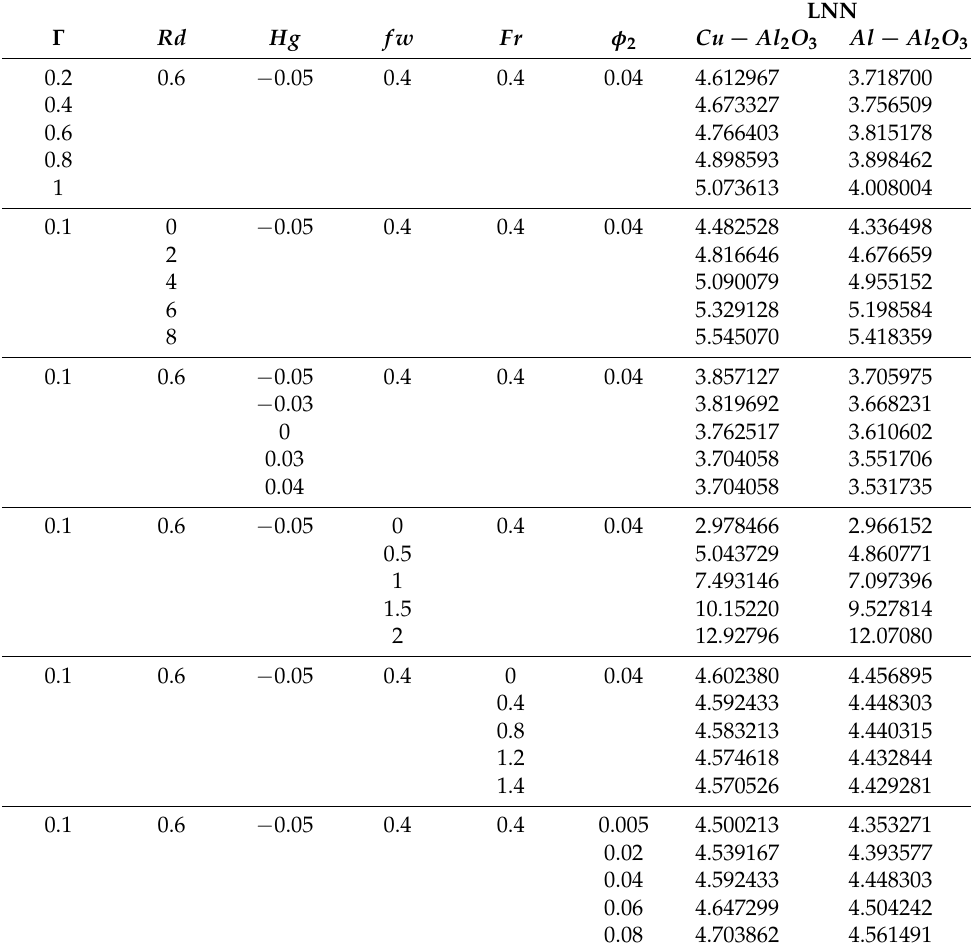
Table 4. The LNN for different values of Γ , Rd , Hg , fw , Fr , φ 2 for both